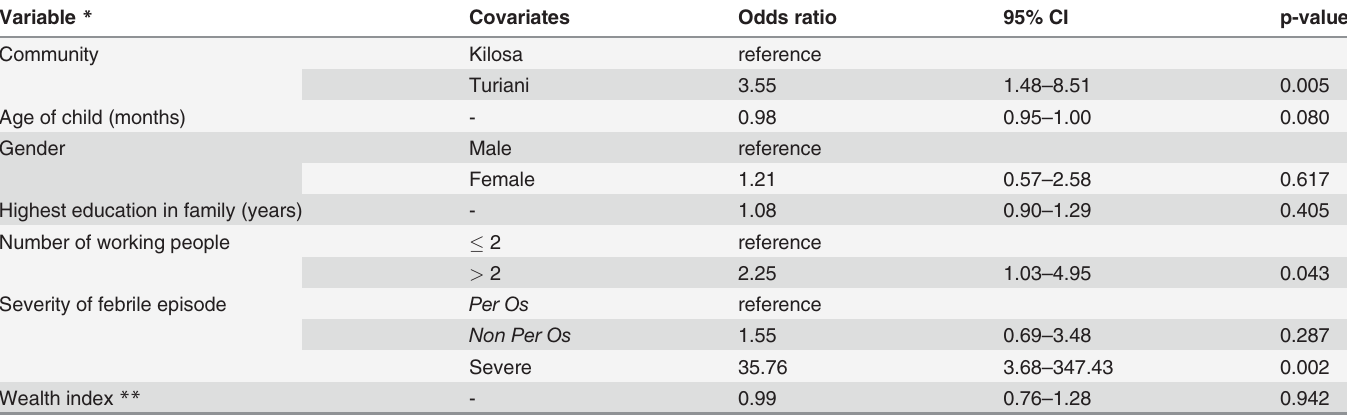
Table 3. Determinants of attending healthcare facility for acute febrile illness based on a multivariable logistic regression model (169